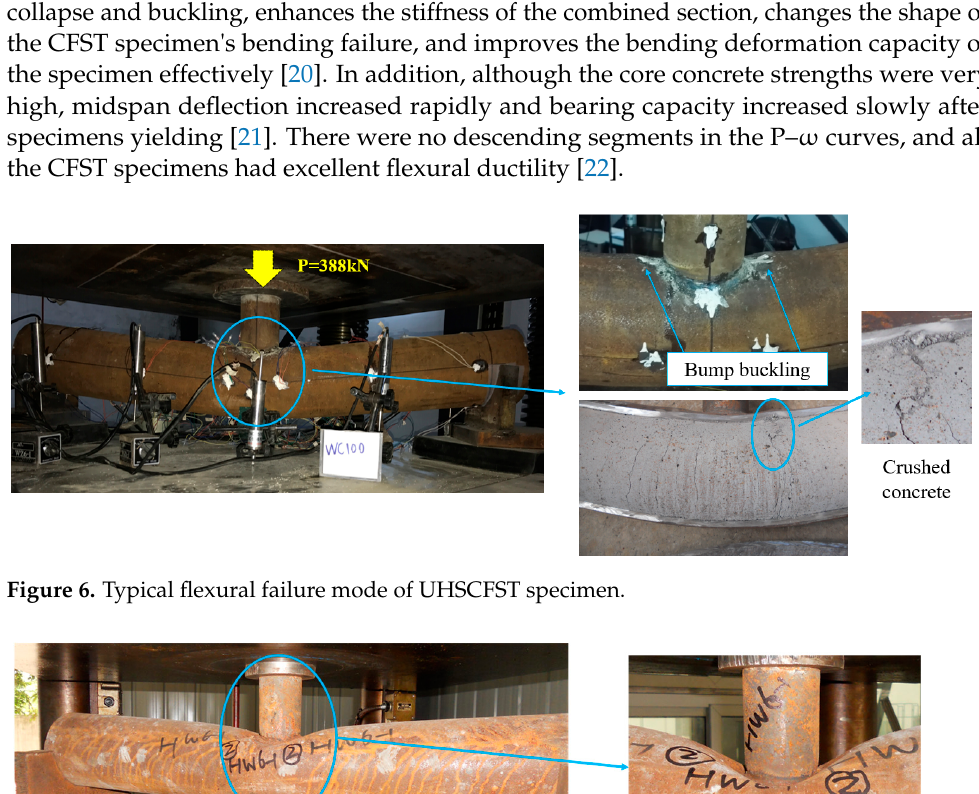
Figure 7. Typical failure mode of hollow steel tubes under bending [19].